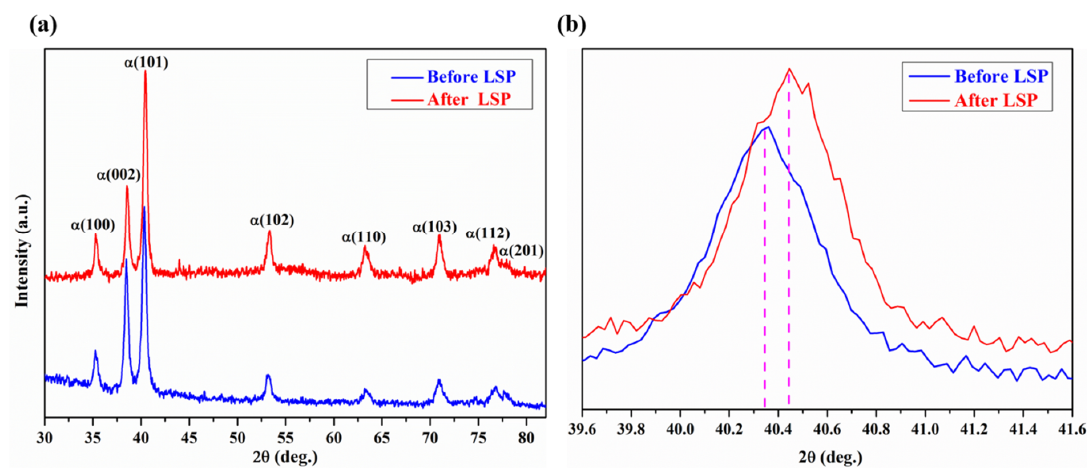
Figure 5. ( a ) XRD of the surface layer in SLM Ti64 samples before and after LSP; ( b ) diffraction peaks shifting of α (101).